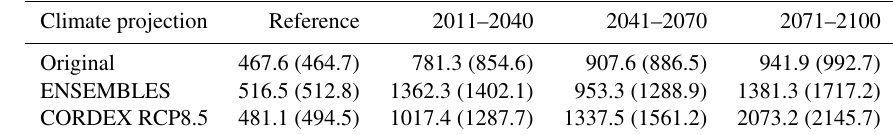
Table 1. Median (and mean) of damages per period and scenario projection (million EUR).